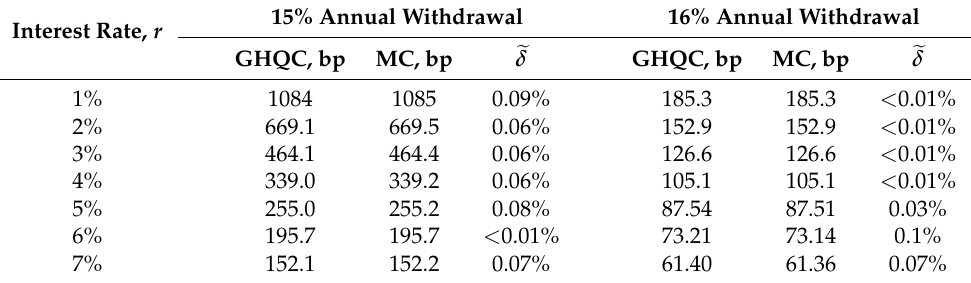
Table 2. Fair fee α in bp as a function of interest rate r for the GMAB with the annual ratchet and static quarterly withdrawal of 3.75% and 4% of the wealth account (15% and 16% annually respectively). The penalty threshold (pension type account) is set at 15% annually. The contract maturity is T = 10 years and volatility is σ = 20%. (cid:101) δ is the relative difference between Monte Carlo (MC) and GHQC results. 15% Annual Interest Rate, r